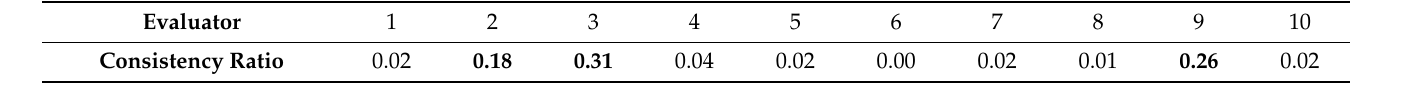
Table A1. Consistency ratio value for each